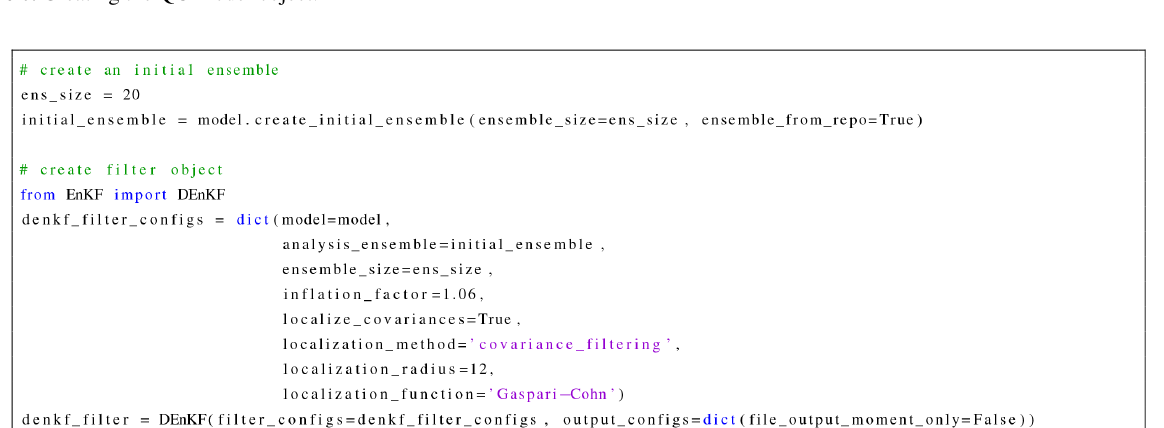
Figure 6. Creating the QG model object.